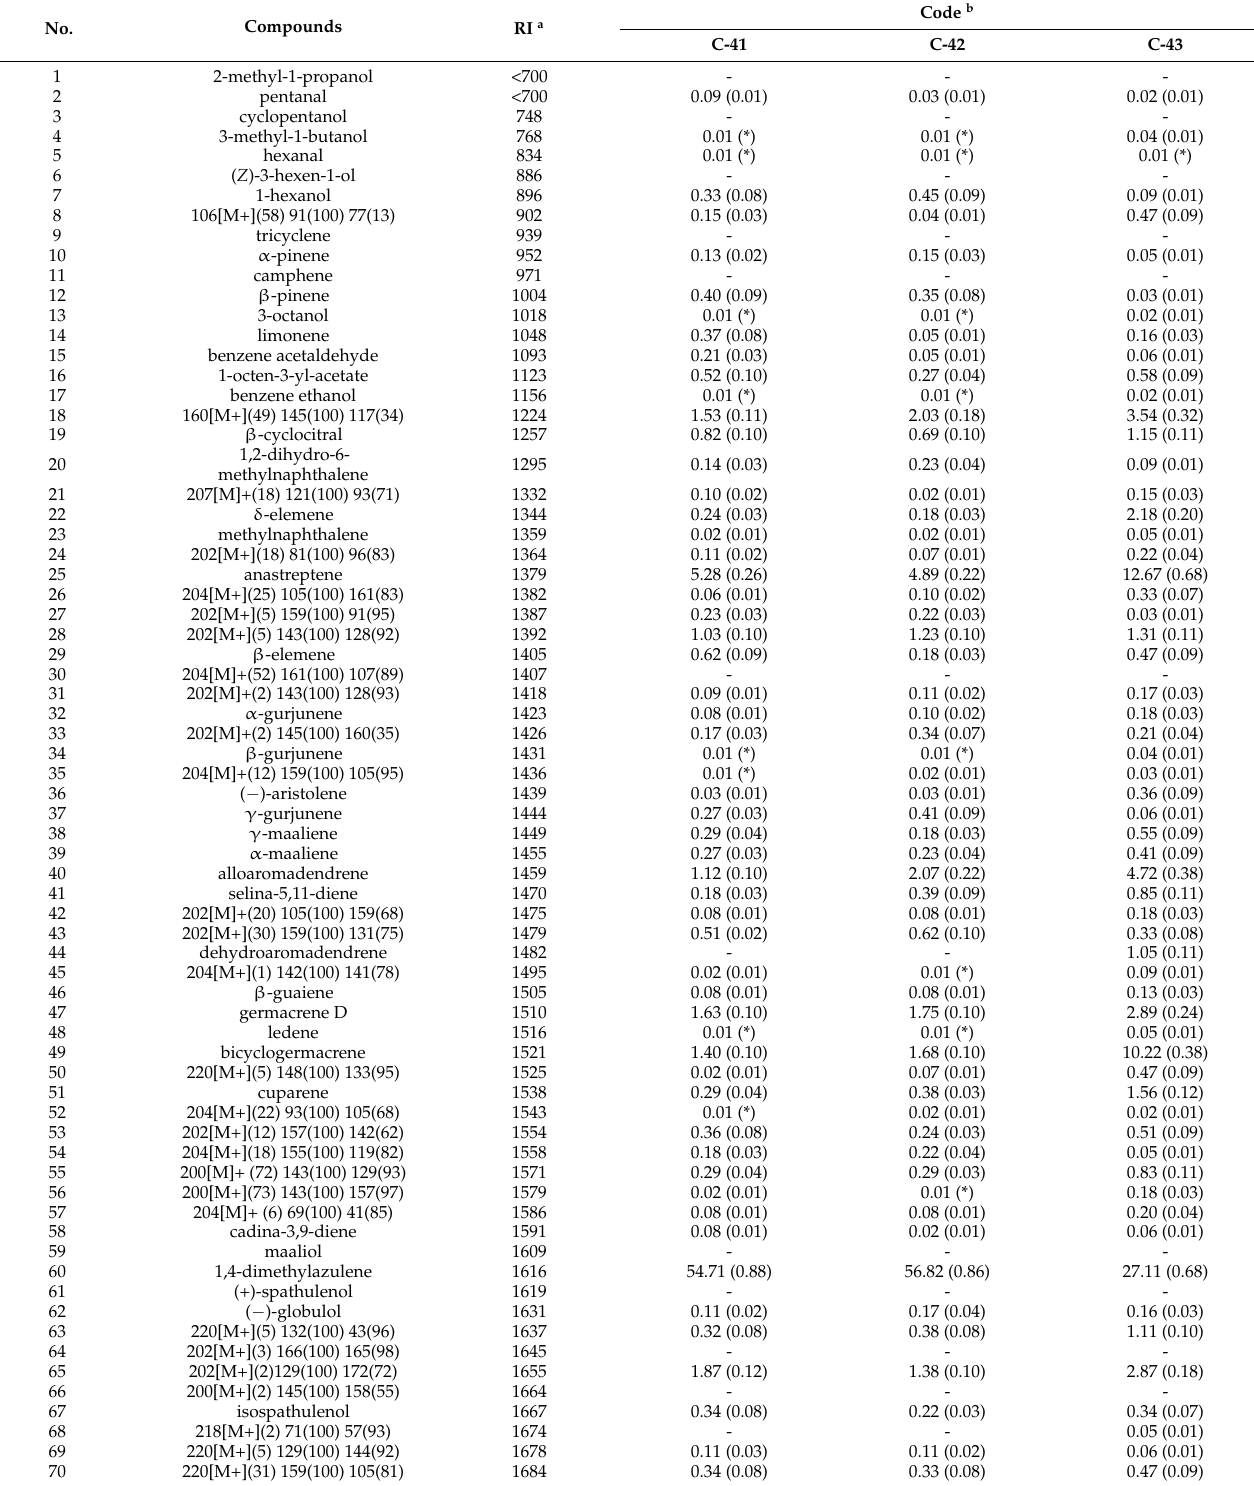
Table 10. Volatile compounds detected in the samples